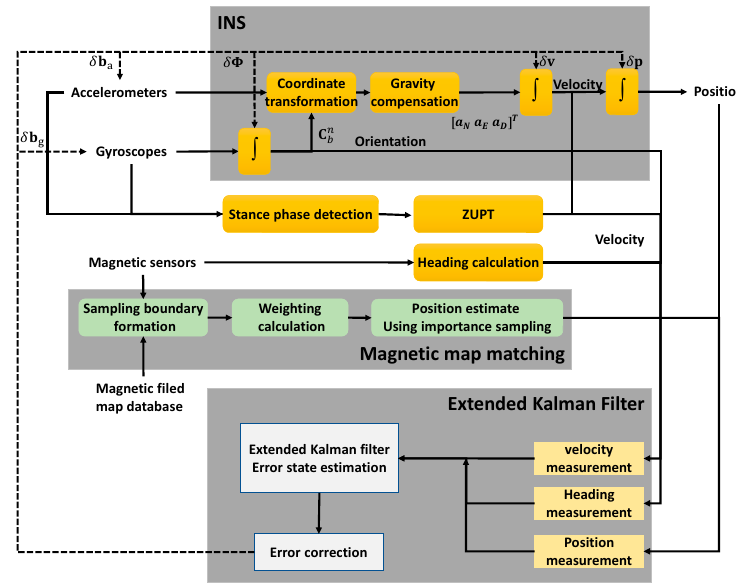
Figure 7. Map-matching-aided pedestrian dead reckoning (MAPDR) algorithm block diagram.